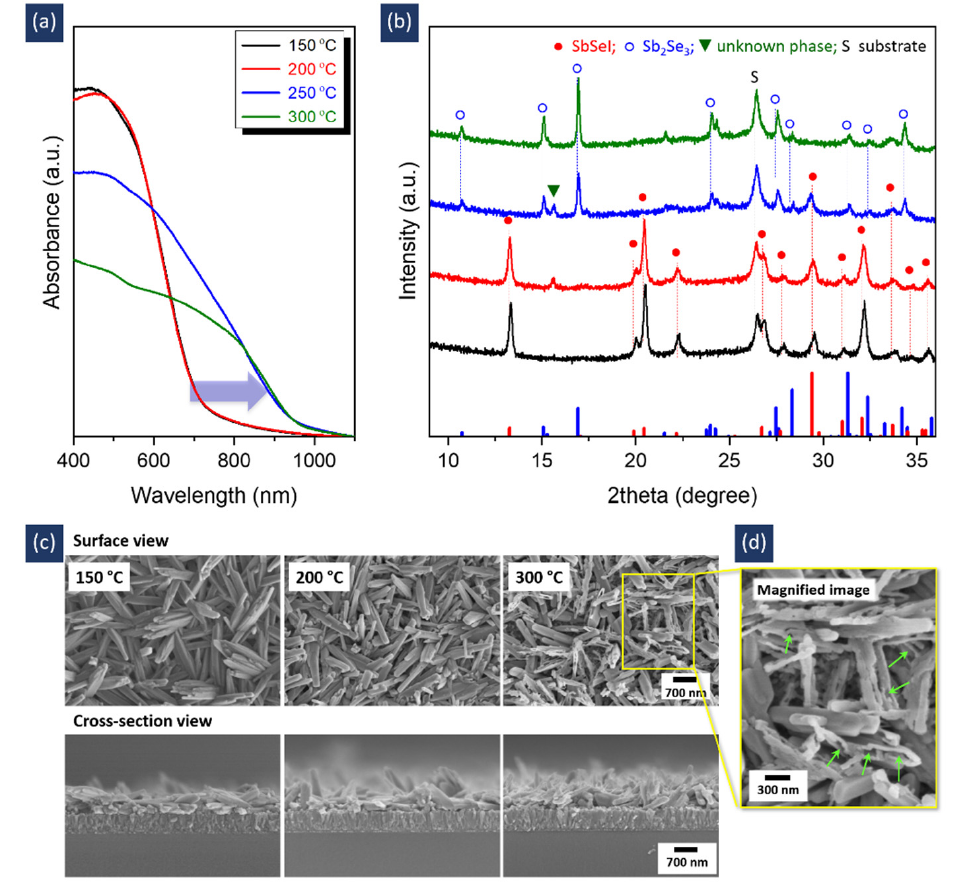
Figure 3. ( a ) Absorption spectra, ( b ) XRD patterns, and ( c ) FESEM images of samples prepared at different annealing temperatures. ( d ) Magnified image, marked by a yellow box in ( c ). All samples were fabricated using the precursor solution with a Sol A:Sol B molar ratio of 1:1.5. In ( b ), two reference patterns of Sb 2 Se 3 ((ICDD # 98-065-1518) and SbSeI (ICDD # 98-003-1292) are shown as blue columns and red columns, respectively.